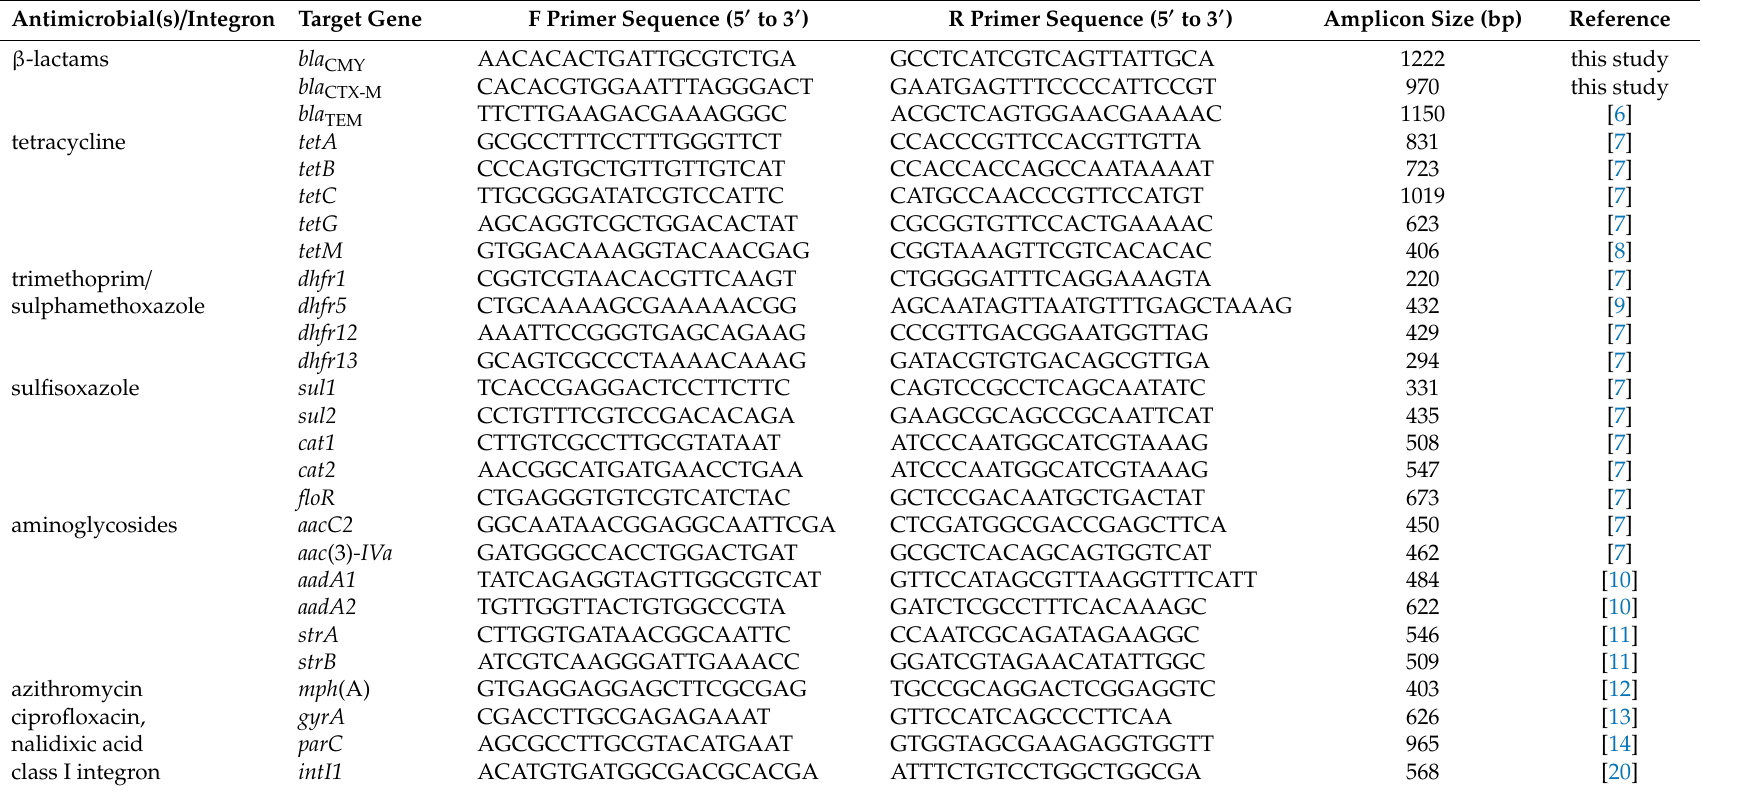
Table 1. Primers used for the identification of antimicrobial resistance genes and integron in resistant E. coli isolates from surface water. Antimicrobial(s) / Integron Target Gene F Primer Sequence (5 (cid:48) to 3 (cid:48)